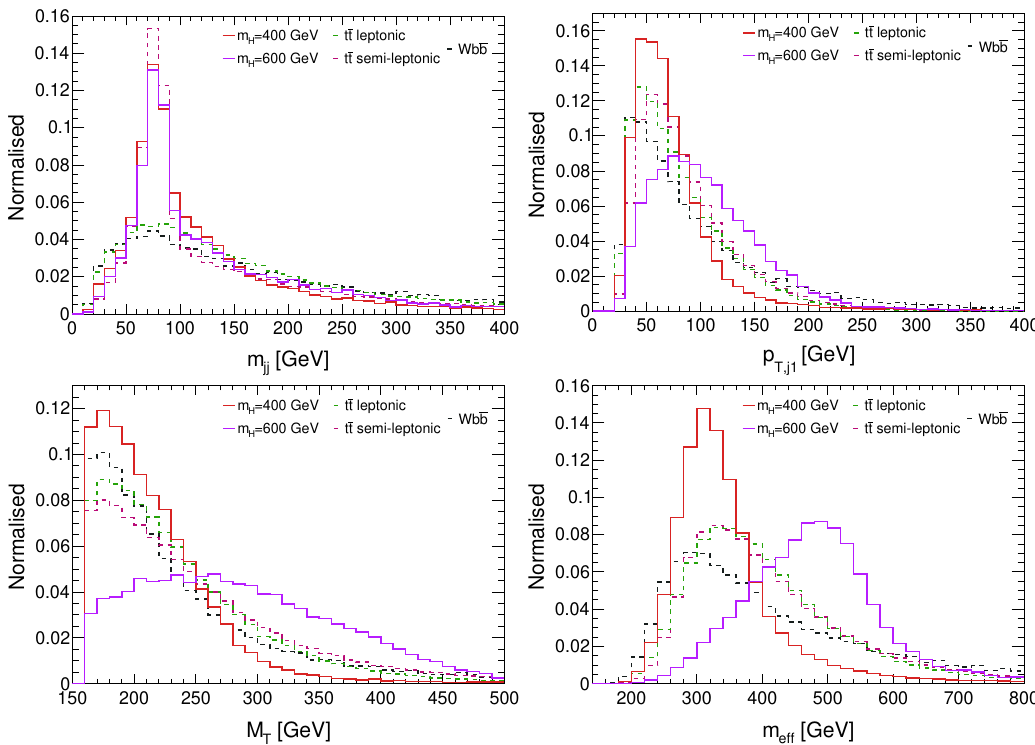
Figure 33 . The m jj , p T;j , M T and m e(cid:11) distributions for the semi-leptonic category for m H = 400 1 and 600 GeV with dominant backgrounds. Here the heavy Higgs boson is searched for in the t (cid:22) t channel. The distributions are shown before doing the multivariate analysis.